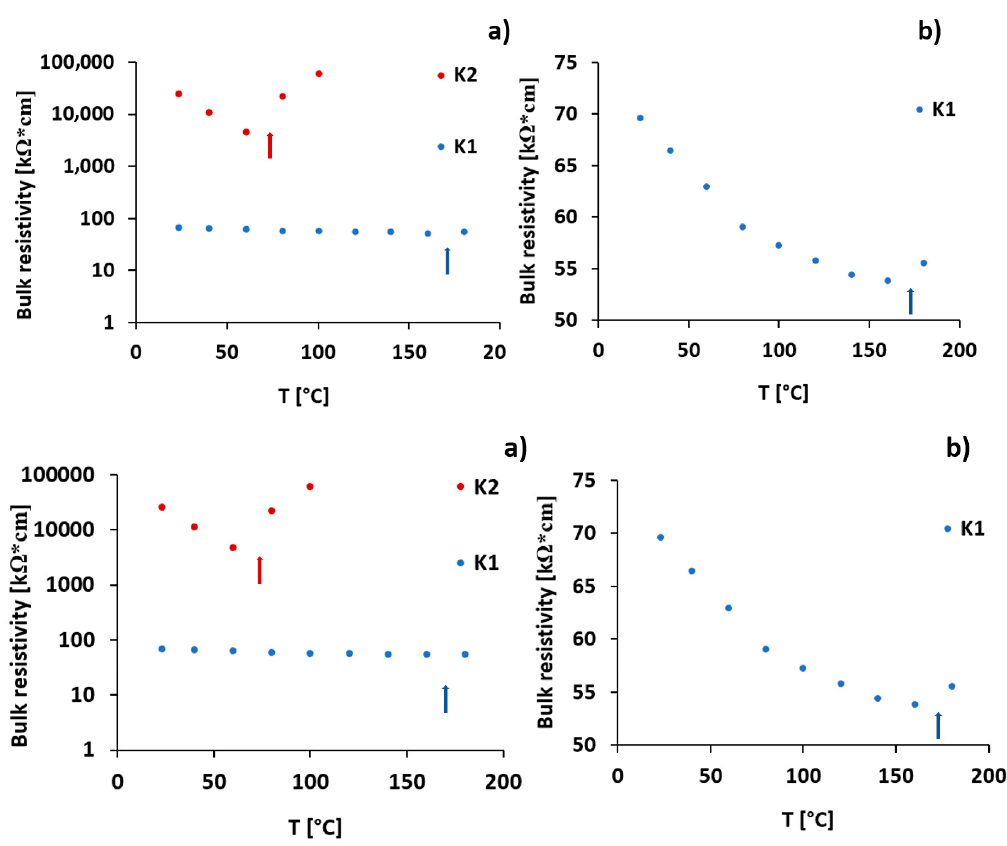
Figure 3. Bulk resistivity changes upon temperature increase for samples K1 and K2. ( a ) Logarithmic scale, and ( b ) linear scale concentrating on sample K1. Arrows show the temperature at which cracks propagated from electrodes towards the exterior.